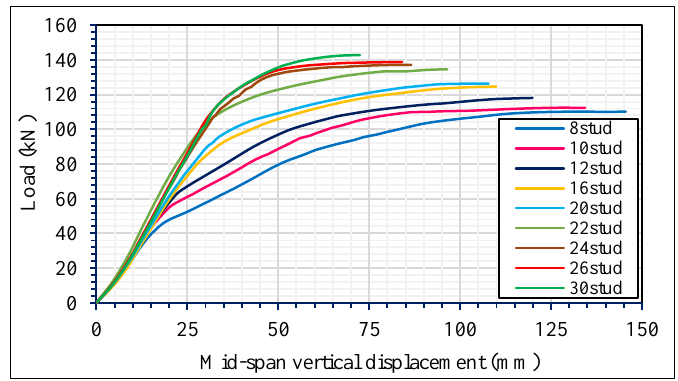
Figure 16. Partial interaction effect on the load-deflection relationship of the curved composite